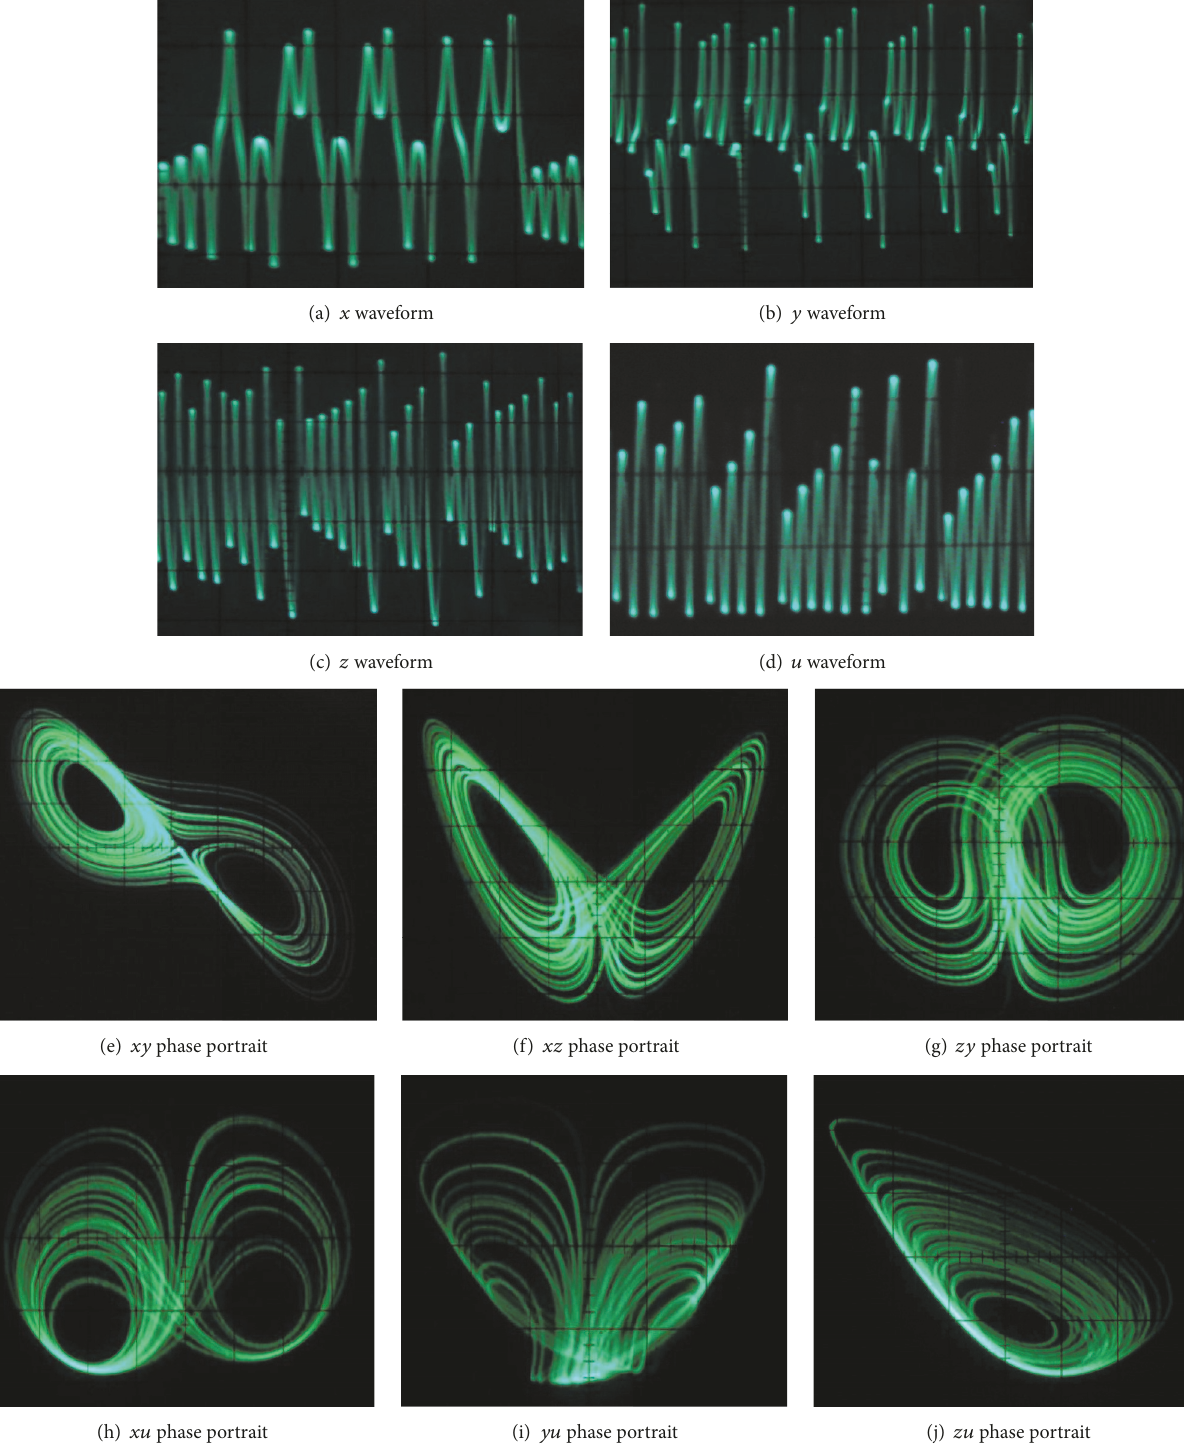
Figure 28: The output waveforms and phase portraits signal photos of the novel 𝑧 - 𝑢 - 𝑦 hyperchaotic